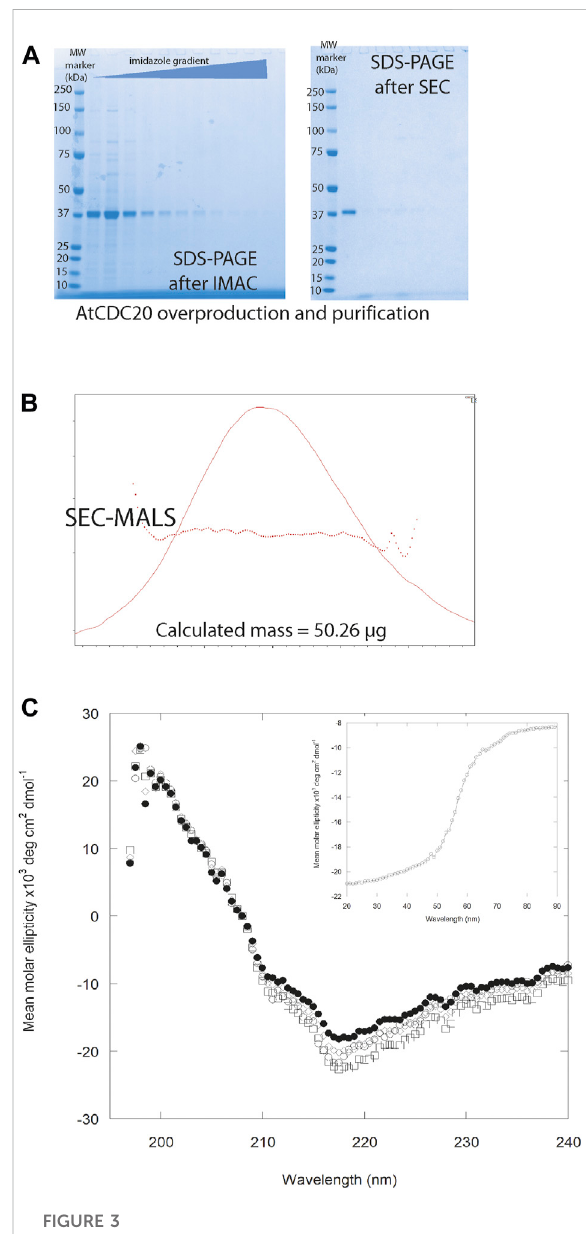
FIGURE 3 (A) AtCDC20.1 WD40 puri fi cation by IMAC and after SEC. In both cases, the eluted fractions were compared against the Precision Protein Plus Molecular Weight Marker (M). (B) The SEC- MALS pro fi les con fi rmed AtCDC20.1 WD40 is a globular protein domain of ca. 40 kDa. (C) Far-UV spectra of AtCDC20.1 WD40 at pH 4.0 ( ○ ), 6.0 ( C ), 8.0 ( □ ), and 9.0 ( ◊ ). Inset: CD thermal denaturation pro fi le of AtCDC20.1 WD40 recorded